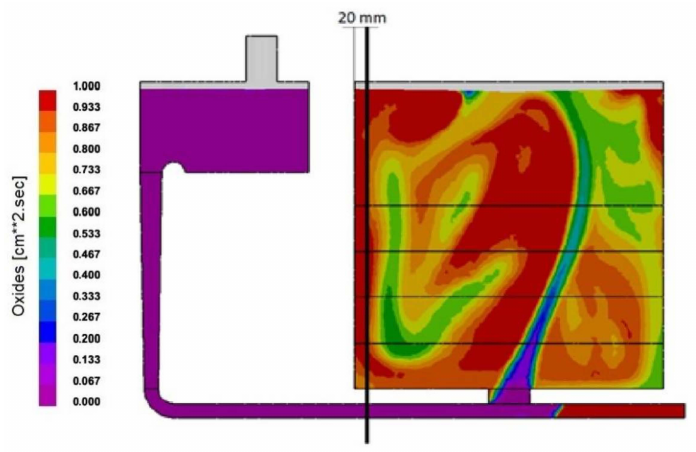
Figure 11. Location of porosity